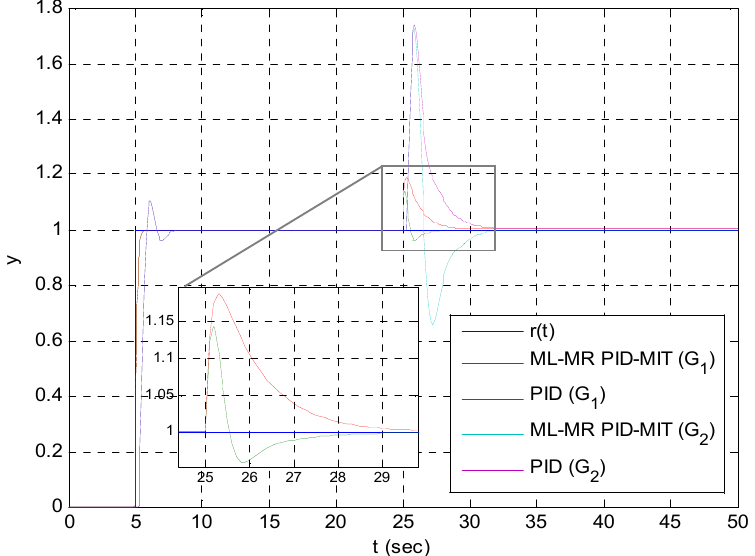
Figure 3. Comparison of disturbance rejection performance of ML-MR PID-MIT control and classical